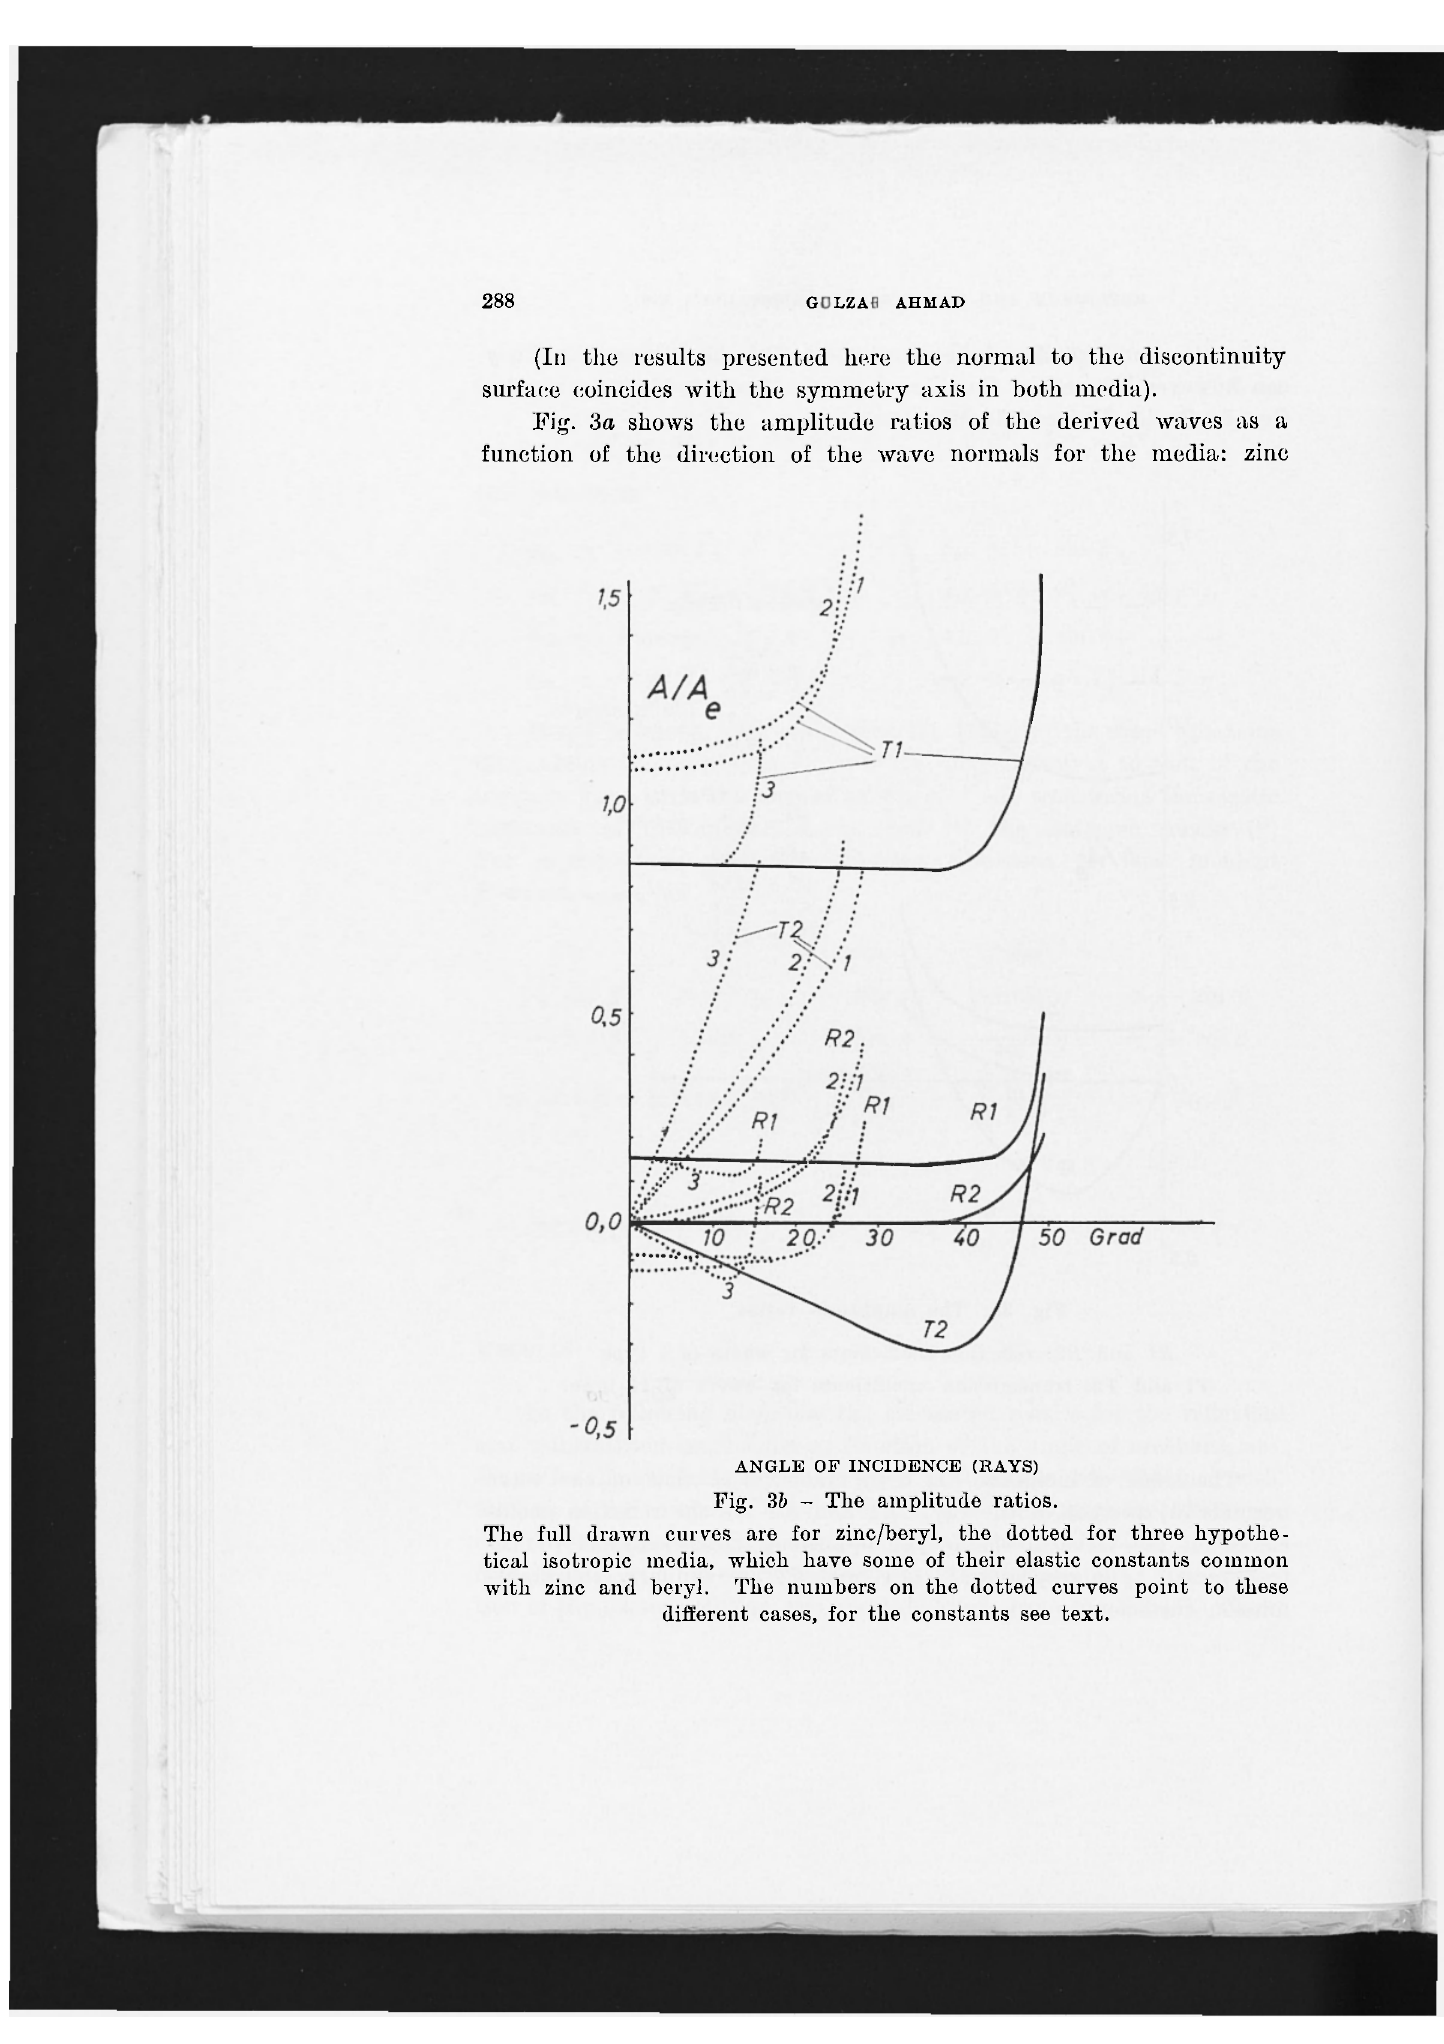
Fig. 36 - The amplitude